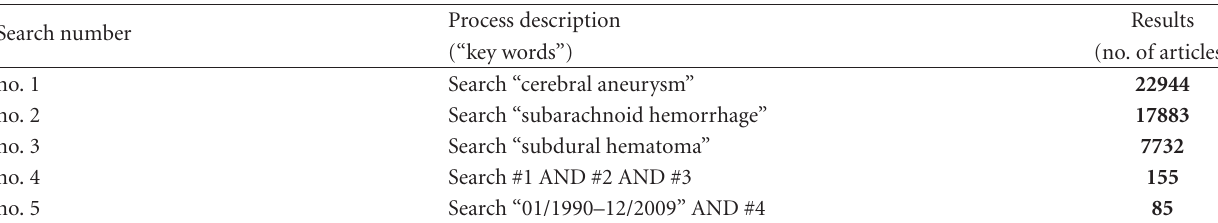
Table 1: Search Strategy ∗